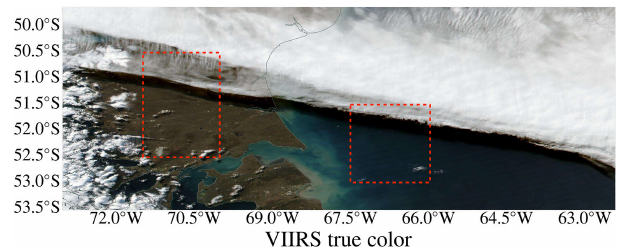
Figure 4. VIIRS-NPP true-colour image of southern Chile and Ar- gentina on 3 August 2019. The land and water regions belonging to the spectra of Fig. 5 are indicated by red dashed